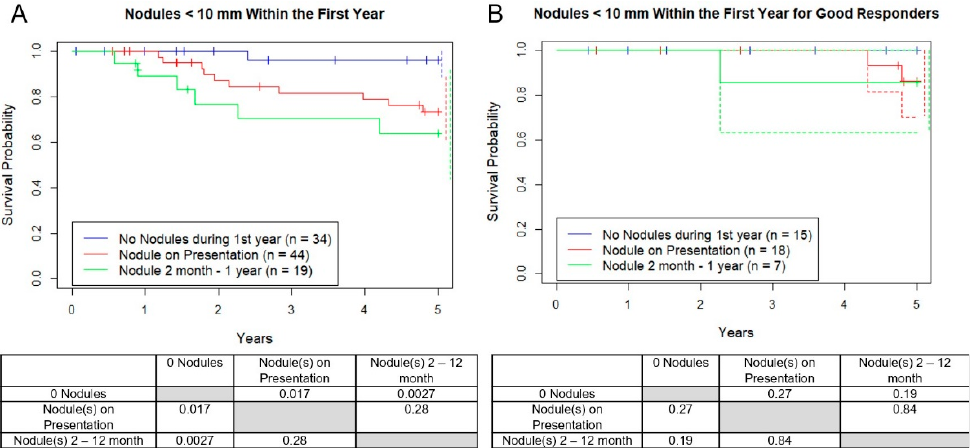
Figure 6. Kaplan–Meier curves demonstrating survival probability vs. years. Groups are separated by number of micronodules at diagnosis vs. those who developed nodules after initiation of systemic therapy within one year of diagnosis (2–12 months from diagnosis) for ( A ) all patients and ( B ) patients categorized as “good responders.” Dotted lines represent 95% confidence intervals for respective